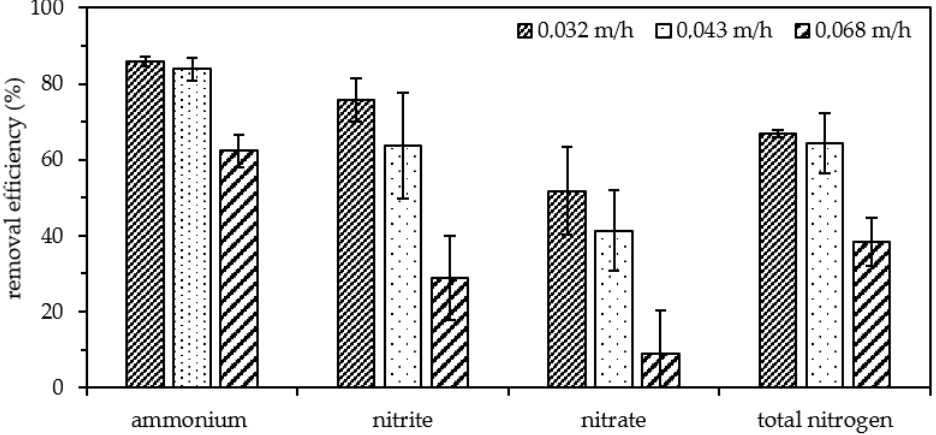
Figure 4. Nitrogen compound removal efficiencies depending on the filter velocity (matrix: Elbe- /tap water (1:10); v F = 0.032, 0.043, 0.068 m/h; c 0 (NH 4+ ) = 4.3 mg/L; c 0 (NO 2 − ) = 5.7 mg/L; c 0 (DOC) = 2.5 mg/L; pH: 7.8; T = 22 °C; n = 3).